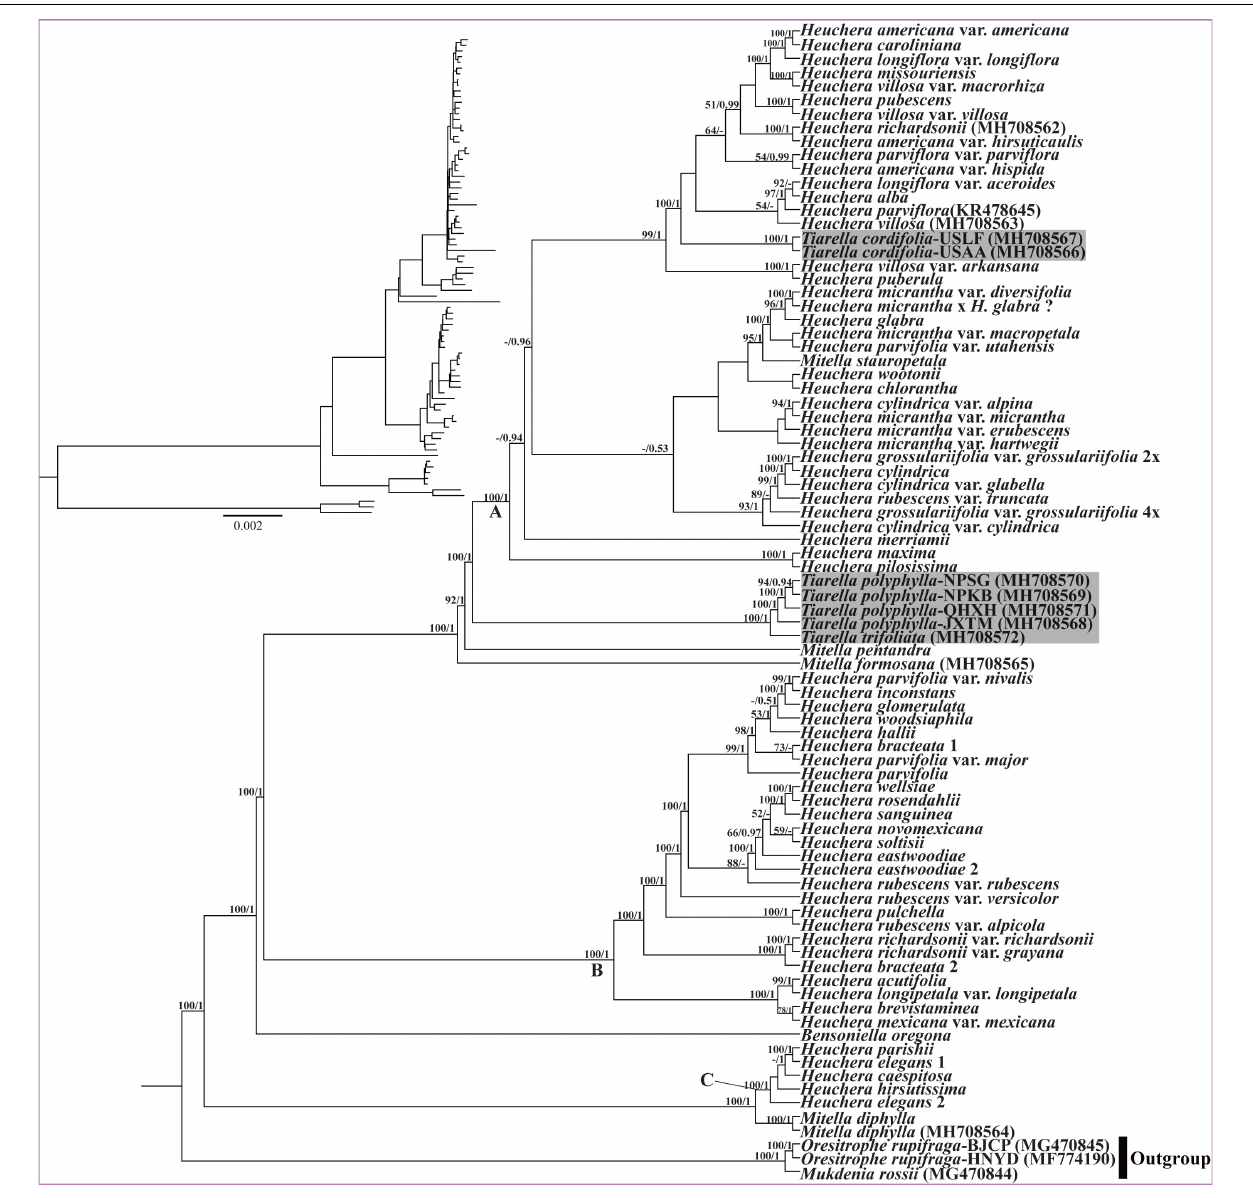
FIGURE 7 | Phylogenetic tree reconstruction using maximum likelihood (ML) based on whole plastome sequences. The inset topology in the upper left shows the relative branch lengths in per-site substitutions. Numbers above the branches represent ML bootstrap/Bayesian posterior probability (BS/PP). Hyphen indicate a bootstrap value or posterior probability < 50%. Clade labels follow those for chloroplast clades recovered in Folk et al. (2017). Gray highlighted labels indicate the position of Tiarella